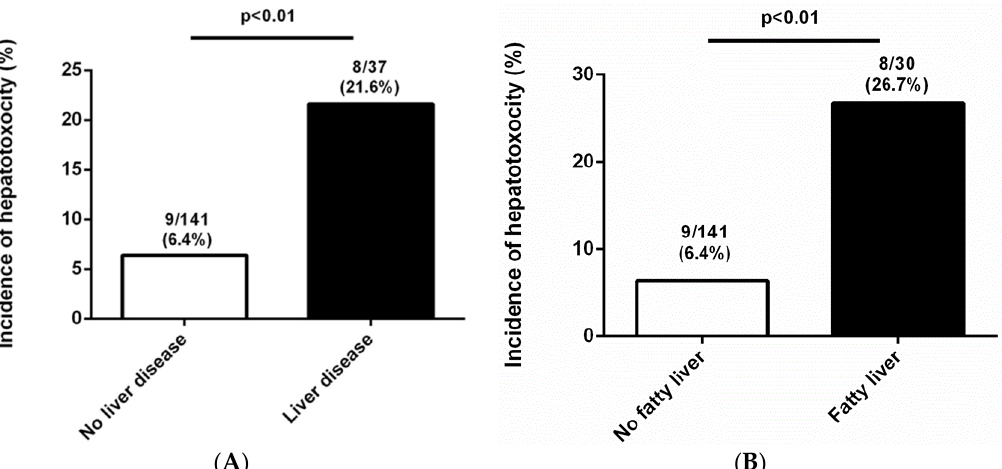
Figure 2. ( A ) Incidence of hepatotoxicity between the groups with or without liver disease in patients with gout treated febuxostat. ( B ) Incidence of hepatotoxicity between the groups with or without fatty liver in patients with gout treated febuxostat.